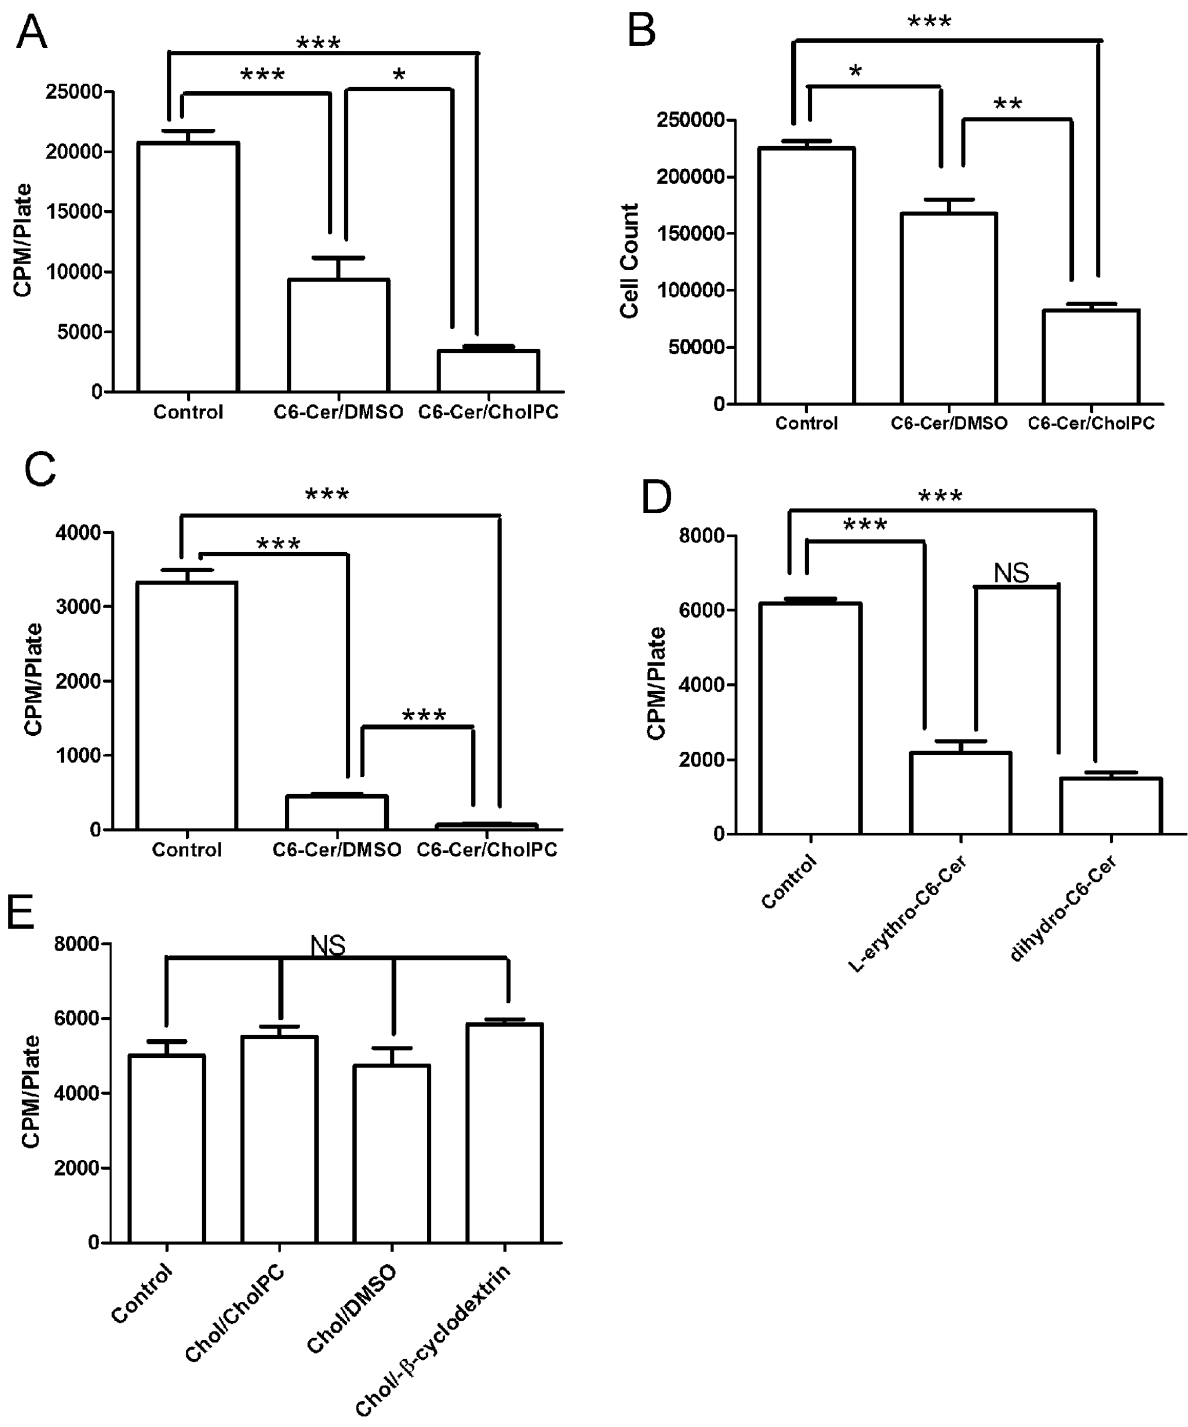
Figure 3. Effect of C6-Cer on cell proliferation. A. FRTL-5 cells were preincubated for 48 h with 0.05 mM C6-Cer/CholPC or C6-Cer/DMSO. [ 3 H]Thymidine incorporation into cellular DNA during the last 4 h was determined. B. Cell proliferation measurement using cell count. Effect of C6-Cer on cell proliferation on FRTL-5 was measured by counting the cells after preincubation for 48 h with 0.05 mM C6-Cer/CholPC or C6-Cer/DMSO. DMSO alone was used as control. Each value gives the amount of cells per plate. C. HeLa cells were incubated with 0.05 mM C6-Cer/CholPC or C6-Cer/DMSO for 12 h. [ 3 H]Thymidine incorporation into cellular DNA during the last 4 h was determined. D. FRTL-5 cells were exposed to 0.05 mM L-erythro-C6- Cer/CholPC or C6-dihydroCer/CholPC for 24 h after which [ 3 H]thymidine incorporation into cellular DNA during the last 4 h was determined. E. FRTL- 5 cells were exposed for 48 h to 0.05 mM Chol/CholPC, Chol/DMSO, or Chol/m- b -cyclodextrin after which [ 3 H]thymidine incorporation into cellular DNA during the last 4 h was determined. Each value is the mean 6 SEM of at least 3 independent experiments. *P , 0.05; **P , 0.01; ***P , 0.001.